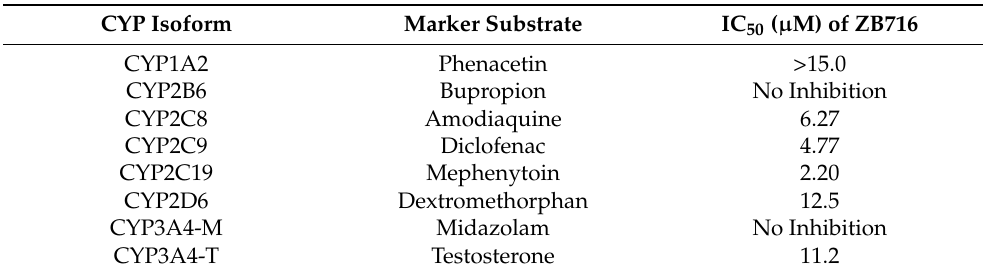
Table 11. The IC 50 values of ZB716 against CYP1A2, CYP2B6, CYP2C8, CYP2C9, CYP2C19, CYP2D6 and CYP3A4 ( n = 3).